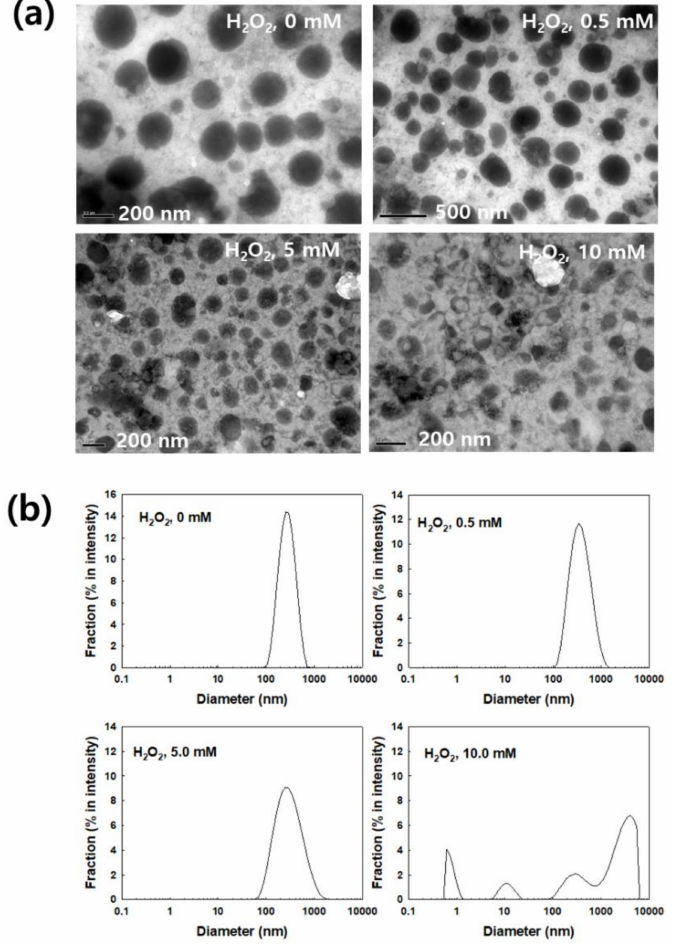
Figure 3. ( a ) The effect of H 2 O 2 on the morphological changes in the nanophotosensitizers of the FaPEGbCDseseCe6 conjugates. ( b ) The effect of H 2 O 2 on the changes of particle size distribution of nanophotosensitizers.